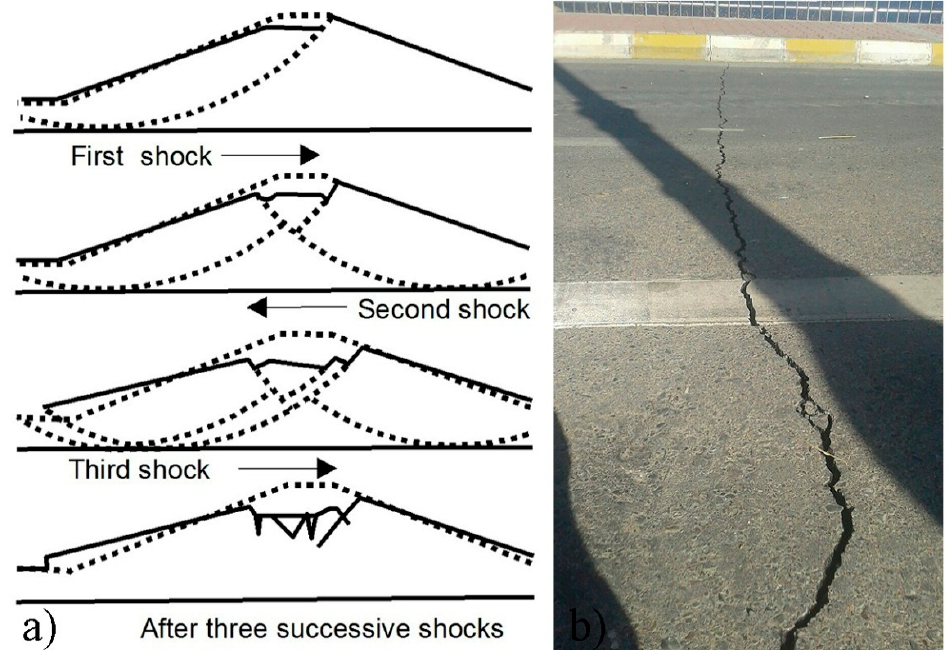
Figure 8. ( a ) The suggested mechanism of embankment dam behaviours during successive earthquake shakings [6], which is believed to be the case for the Darbandikhan dam; ( b ) one of the major cracks that emerged in the Darbandikhan dam after the earthquake.